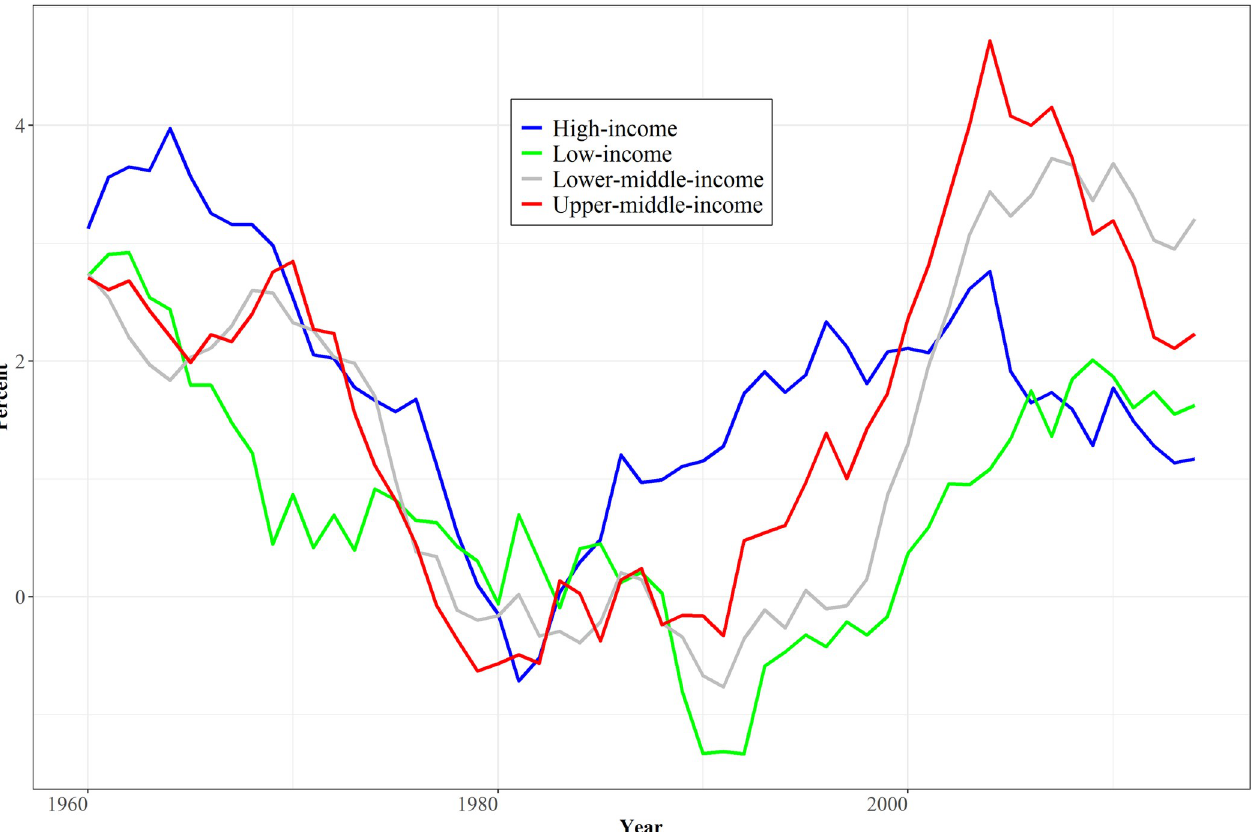
Fig 2. Annual change of TFP in World Bank income categories. Note: Solow residuals using 10-year moving averages; additional countries enter series over time, mostly at beginnings of decades. Source: IFs Version 7.61, building upon data from the Penn World Tables, release 9.0.